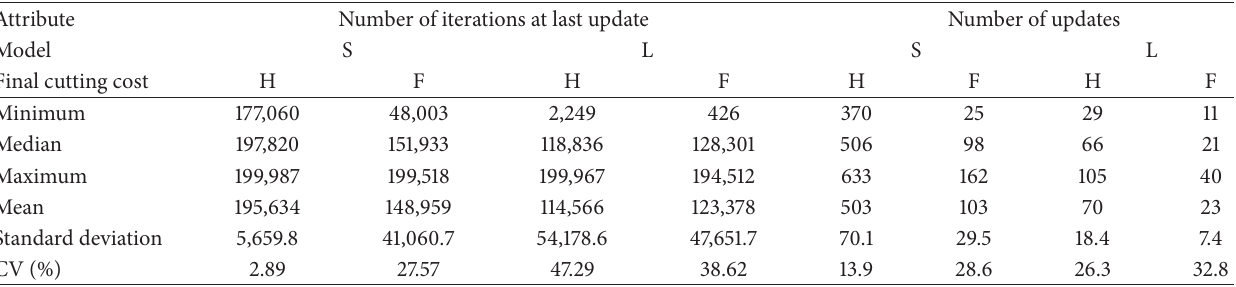
Table 3: Summary of the updating processes of SA.